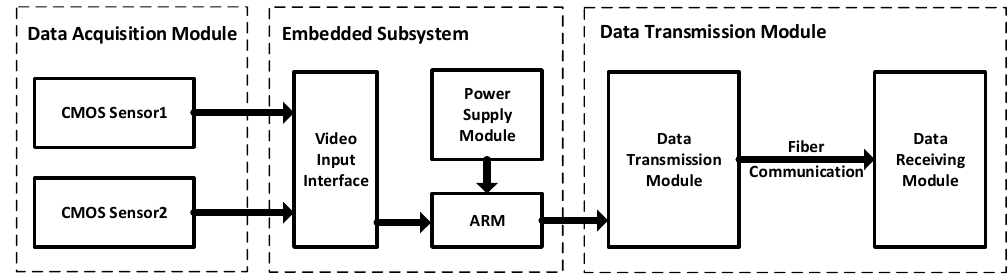
Figure 2. System hardware diagram.